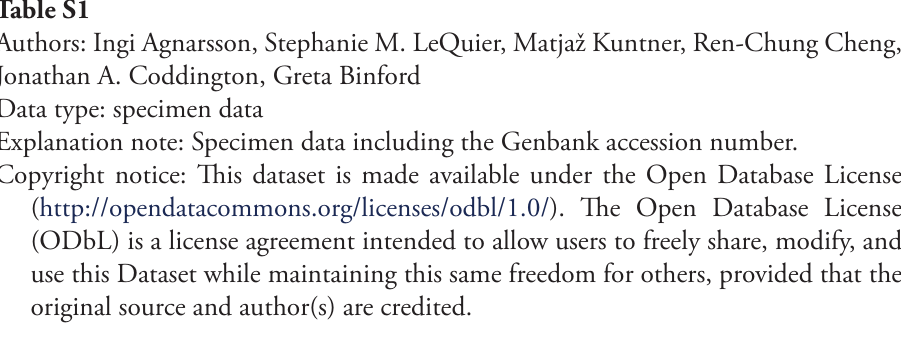
Authors: Ingi Agnarsson, Stephanie M. LeQuier, Matjaž Kuntner, Ren-Chung